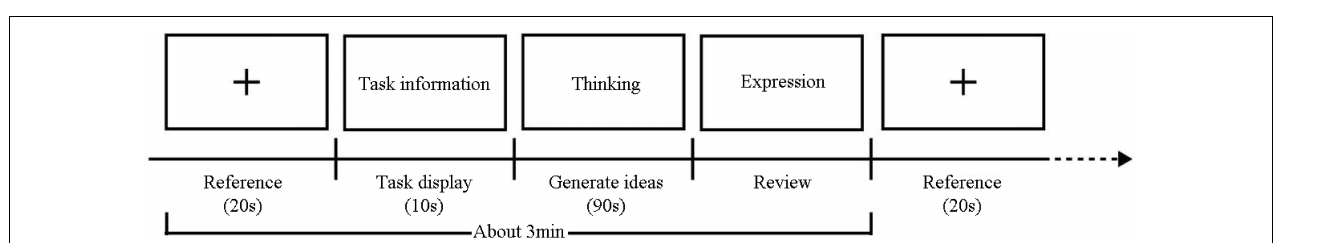
FIGURE 4 | Experiment duration and